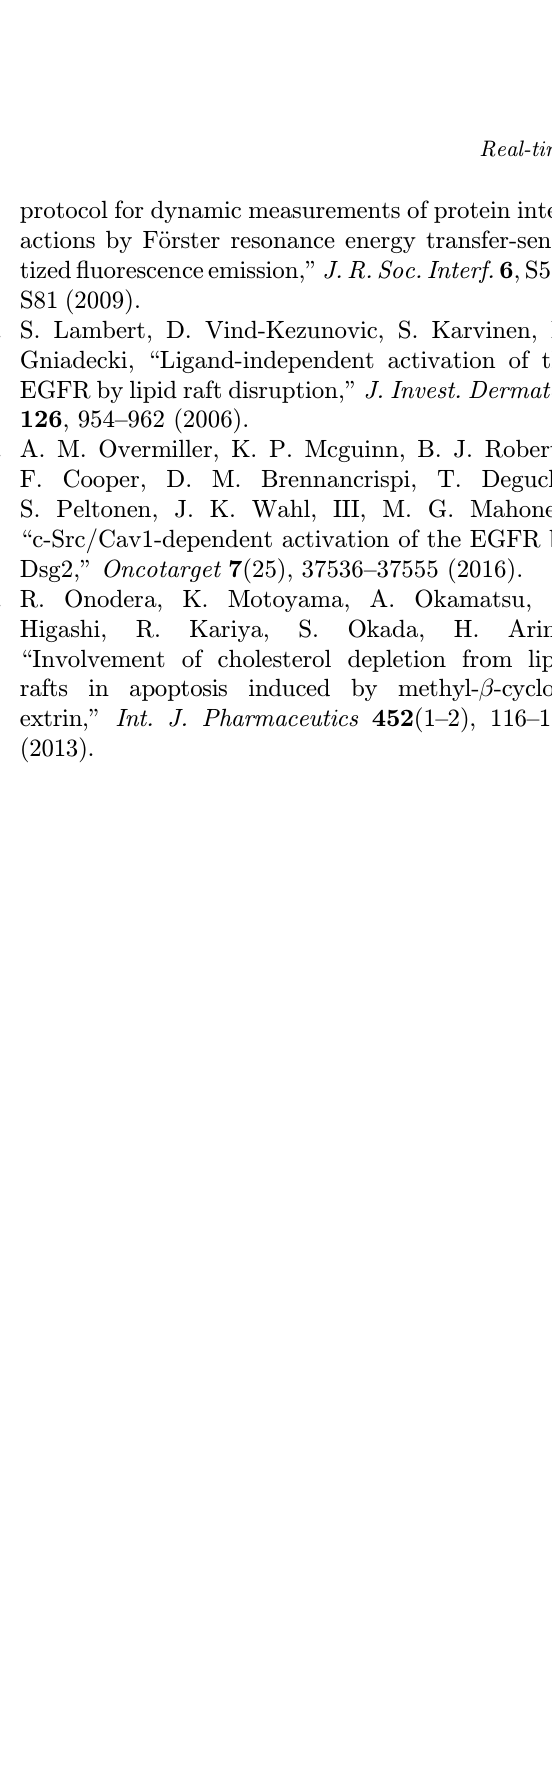
protocol for dynamic measurements of protein